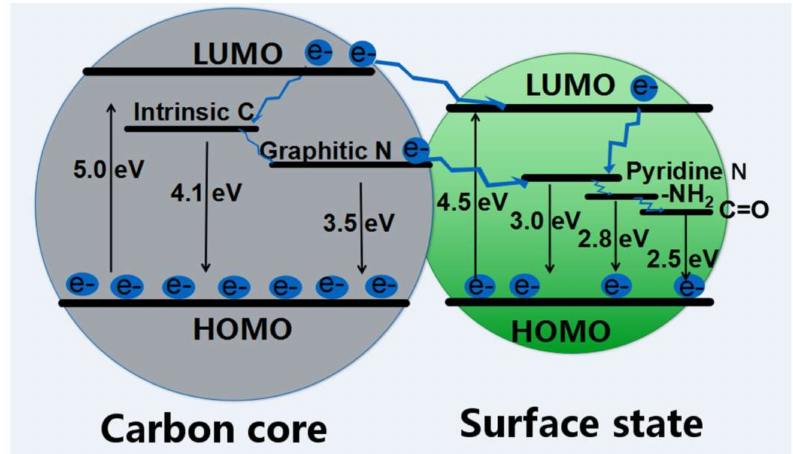
Figure 6. A scheme of energy band structure and possible luminescence process for